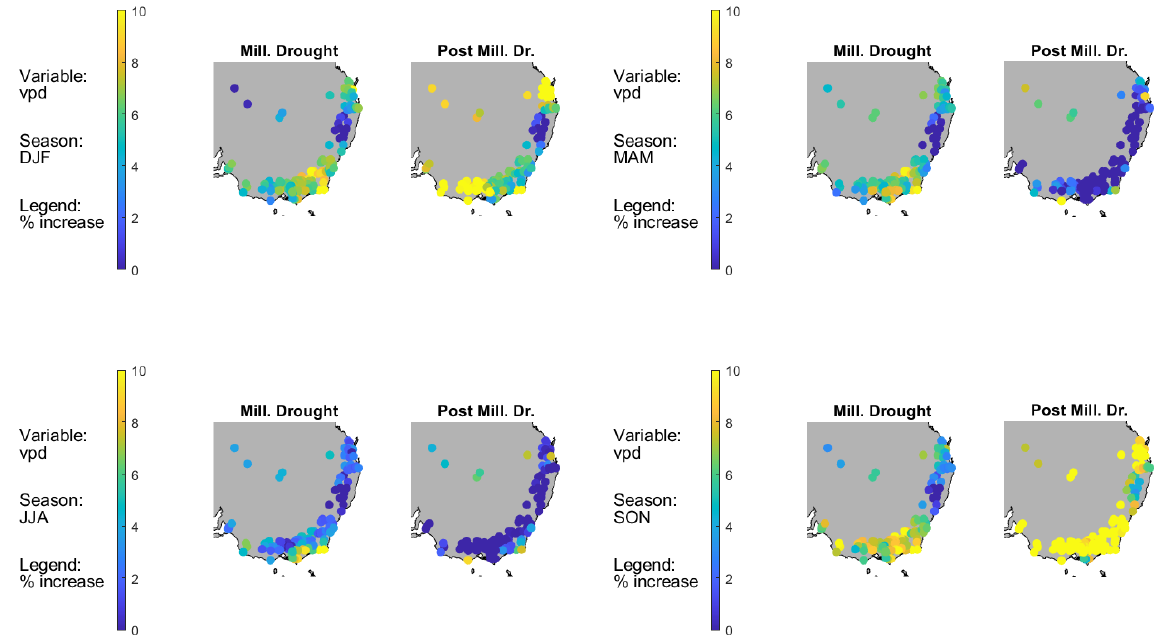
Figure D7. Same as Fig. D1 except for VPD. Based on data from Fowler et al. (2021).